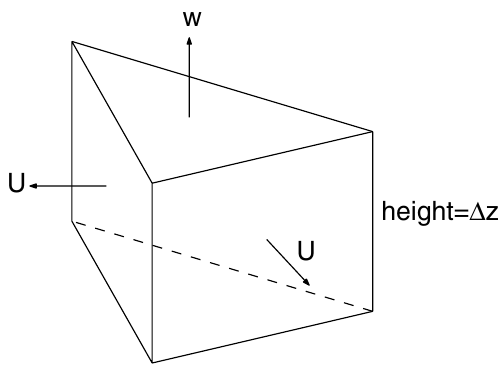
Fig. 2. Depiction of a three-dimensional prismatic grid cell, showing the horizontal velocity U defined normal to the vertical cell faces and the vertical velocity defined at the Voronoi points at the top and bottom of the cell with height D z